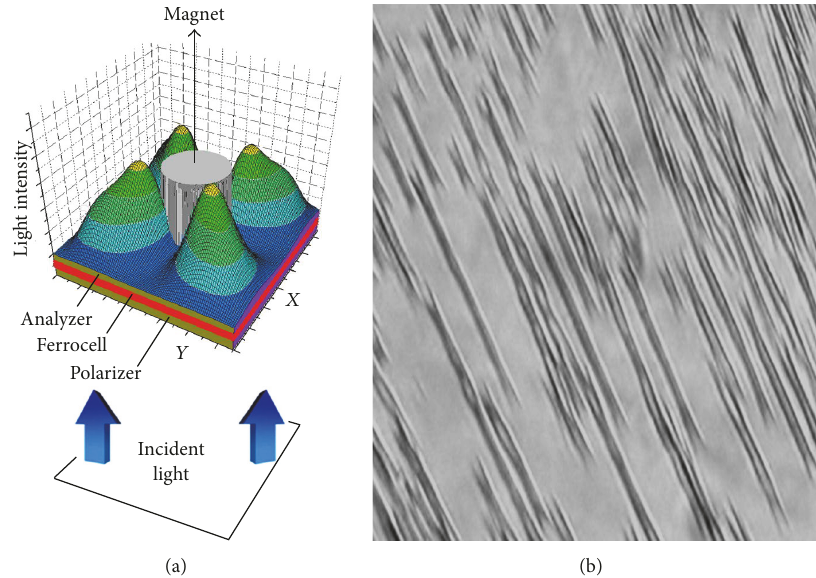
Figure 1: Experimental apparatus in (a), with the surface plot of the light intensity. Optical microscopic view (200x) of the structures formed by a ferrofluid in the presence of a magnetic field (from 100G to 500 G) creating some needlelike structures in (b).